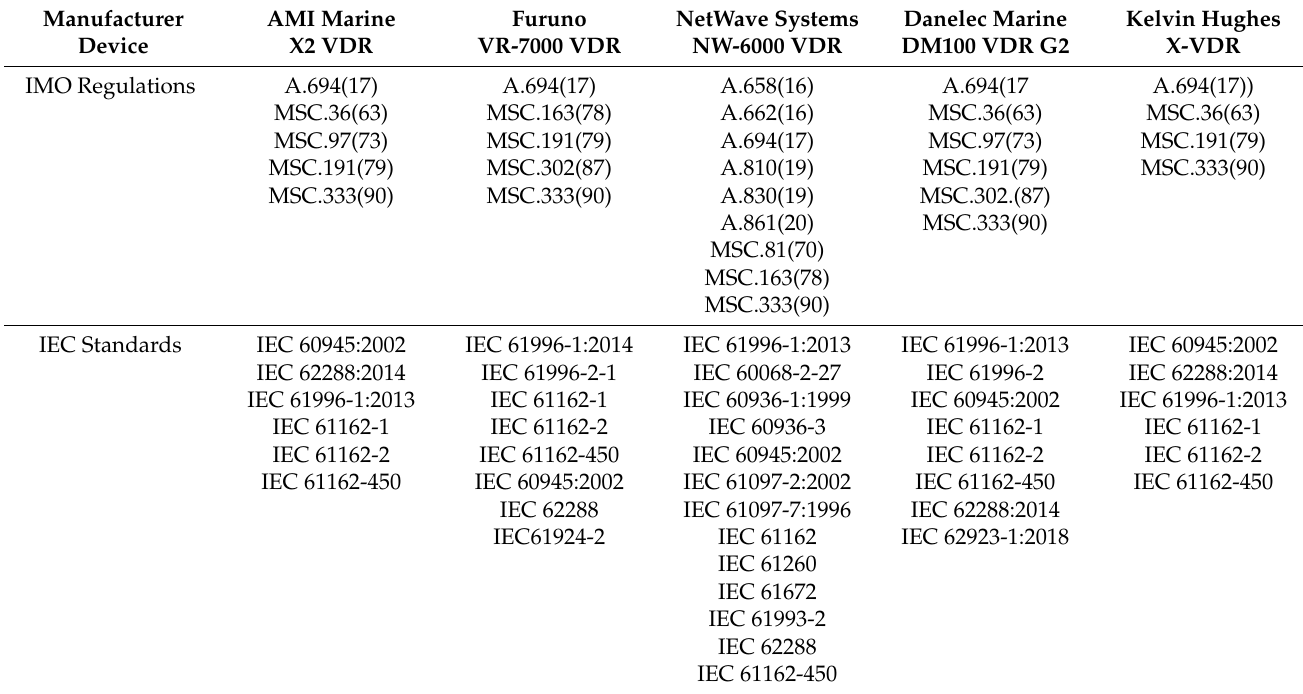
Table 1. Summary of current Standards VDRs comply too